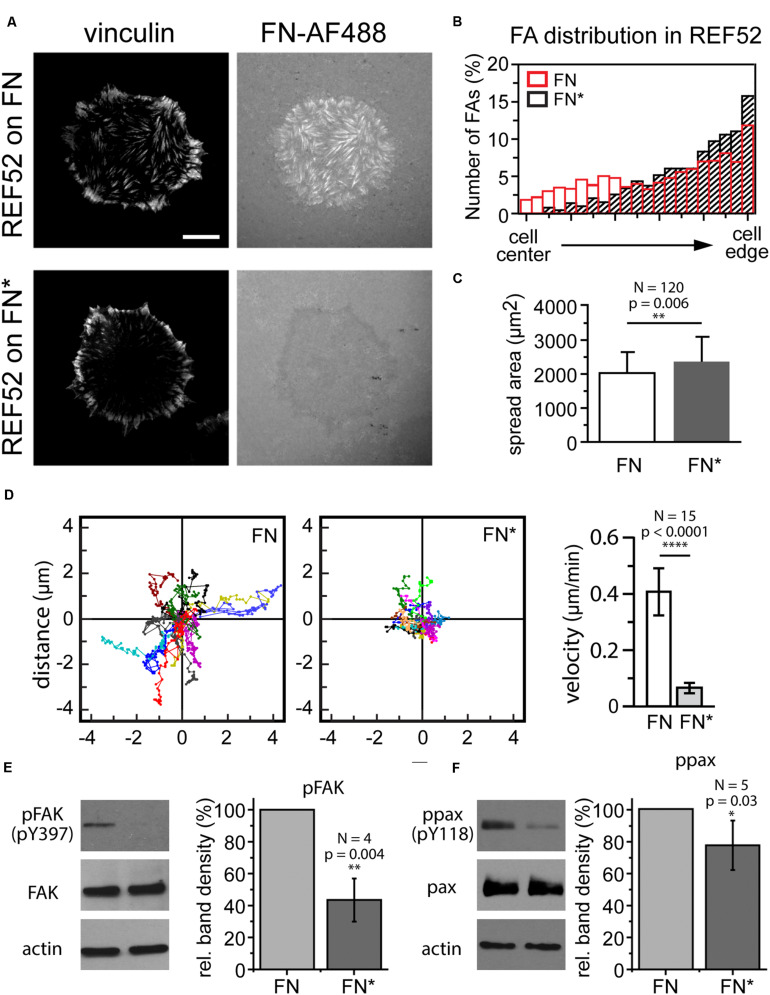
(A) Focal adhesion distribution in REF cells incubated on unexposed (FN) or exposed FN (FN∗) for 4 h. Focal adhesions visualized by vinculin staining. Bar 10 μm. (B) Comparison of focal adhesion localization between cell edge and center. (C) Cell spreading area (mean ± SD) on unexposed and exposed FN. Statistics: unpaired t-test, N = 120, p-value 0.006. (D) Cell scatter plots and cell migration velocity (mean ± SD) of REF cells on unexposed and exposed FN. Statistics: unpaired t-test, N = 15, p-value, p < 0.0001). Western blot analysis of panels (E) FAK and (F) paxillin phosphorylation after incubation on unexposed and exposed FN. Actin bands are loading controls. For each experiment the intensities of the phosphorylated bands were normalized to the respective total FAK or paxillin protein levels, and averaged relative FAK or paxillin phosphorylation levels plotted as mean ± SD. Statistics pFAK: one-way t-test, N = 4, p-value = 0.004, ppax: one-way t-test, N = 5, p-value = 0.03.